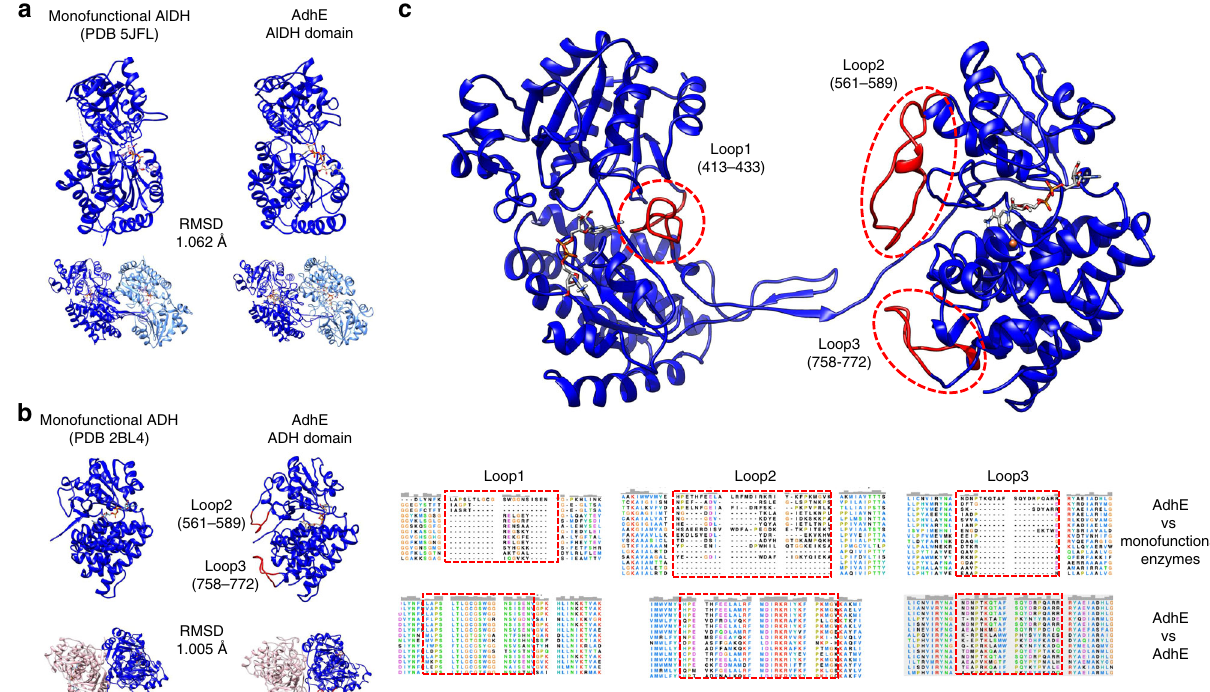
Fig. 3 Comparison of the structure of AdhE in its extended conformation with monofunctional ADH and AlDH enzymes. a The structures of the monofunctional enzyme propionaldehyde dehydrogenase from R. palustris (left) and AdhE AlDH domain (right) are compared. The monomers share the same overall fold. The root-mean-square deviation of atomic positions (RMSD) between the two structures is indicated in the fi gure. Both enzymes assemble as dimers, which are superimposable with each other. b The structures of the monofunctional enzyme lactaldehyde: 1,2-propanediol oxidoreductase from E. coli and AdhE ADH domain are compared. The monomers share the same overall fold. The RMSD between the two structures is indicated in the fi gure. Both enzymes assemble as dimers, which are superimposable with each other. c Localization and conservation of three loops speci fi c to AdhE. These loops are not present in the monofunctional enzymes but are conserved in AdhE